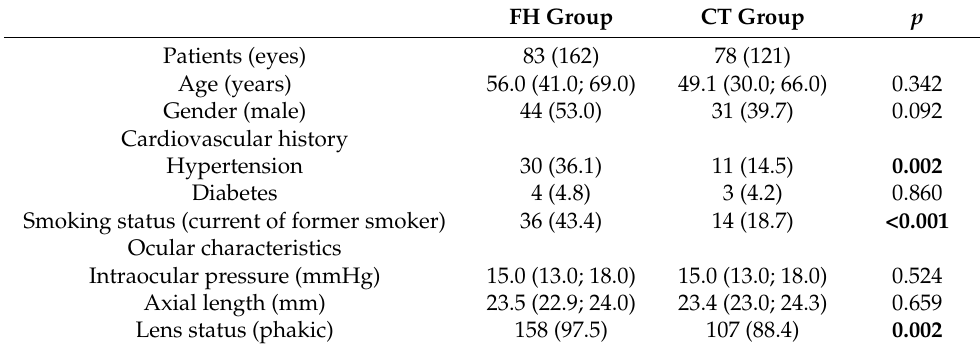
Table 1. Comparison of patient characteristics between familial hypercholesterolemia and control